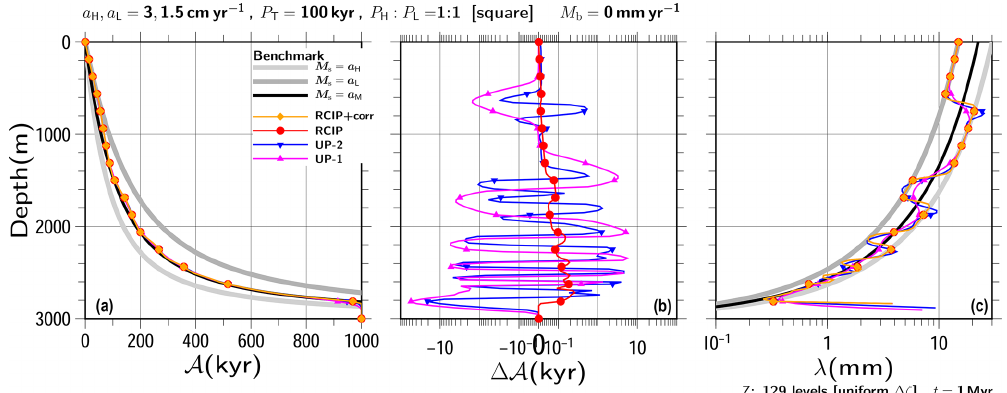
Figure 7. Results of transient experiments with square-wave surface mass balances of a H , a L = 3 , 1 . 5cmyr − 1 , P T = 100kyr, P H : P L = 1 : 1 = 50 : 50kyr, square-wave, M b = 0, and constant H = 3000m. (a) Vertical profiles of the computed age and (c) annual layer thickness at 1000kyr using RCIP+corr , RCIP (overlapped on RCIP+corr ), UP-2 , and UP-1 are shown. The last 500 years are clipped from panel (c) , where the age gradient (inverse of λ ) is close to 0, reflecting the initial condition. (b) The computed age differences at the same depth relative to the result of the RCIP+corr case are shown on a logarithmic scale, except for those near 0, which are shown on a linear scale. For reference purposes, the gray lines indicate benchmark solutions for the constant surface mass balance cases of a H , a L , and a M . Uniform grid spacing of 129 levels is adopted in this simulation.